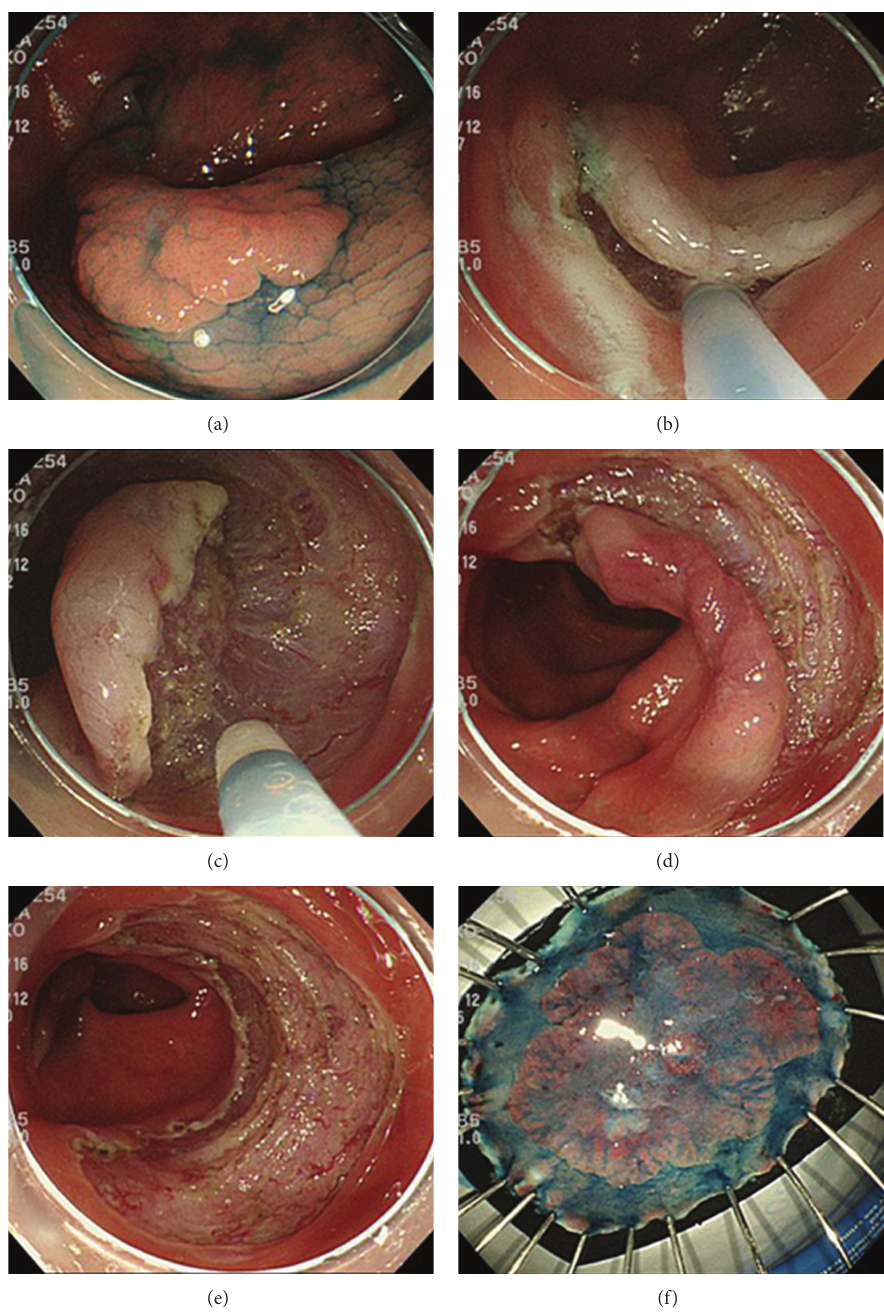
Figure 1: Standard procedure for colorectal ESD. (a) A large (3 × 4cm) laterally spreading tumor-nongranular type in the transverse colon is delineated by use of topical application of indigo carmine. One can also see the frontal part of the disposable hood. (b) The lesion is elevated by submucosal injection of hyaluronic acid solution, and the anal part of the tumor has been incised by use of a Flush-knife. (c) The Flush-knife is used to dissect the submucosa and separate it from muscularis propria. (d) When approximately half of the lesion has been separated from the muscularis propria, the mucosal incision is completed around the lesion. (e) The lesion has been resected en bloc, and the remaining ulcer is examined for potential perforations and exposed blood vessels to coagulate. (f) The resected specimen is stretched and nailed to facilitate histological